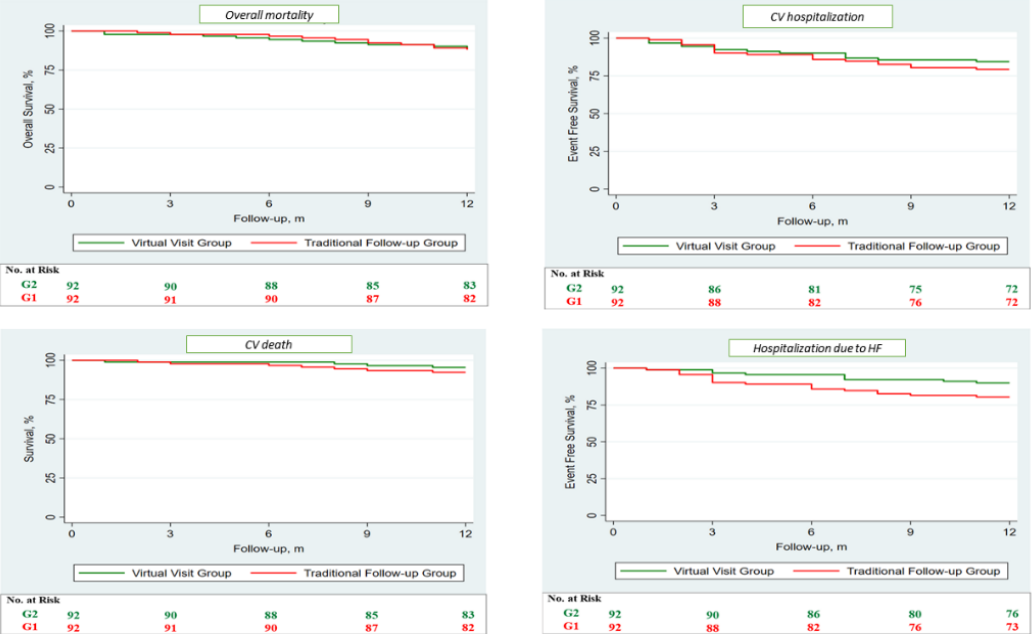
Figure 3. Survival analysis regarding the single secondary endpoints performed through Kaplan–Meier method. Survival analysis demonstrates no differences regarding the single secondary endpoints of overall mortality, cardiovascular death, cardiovascular hospitalization, and hospitalization due to HF between the two groups. G1 (red) is the group followed up through traditional in-person visits, while G2 (green) represents the virtual visit group. CV: cardiovascular; HF: heart failure.